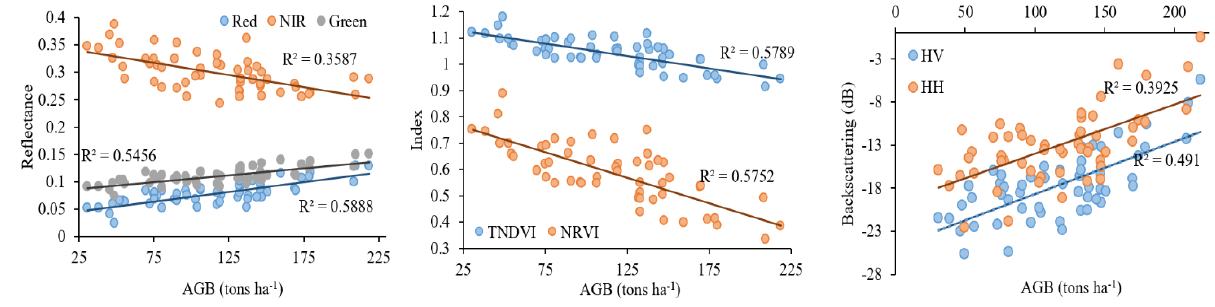
dB for HV and -8 dB for HH.